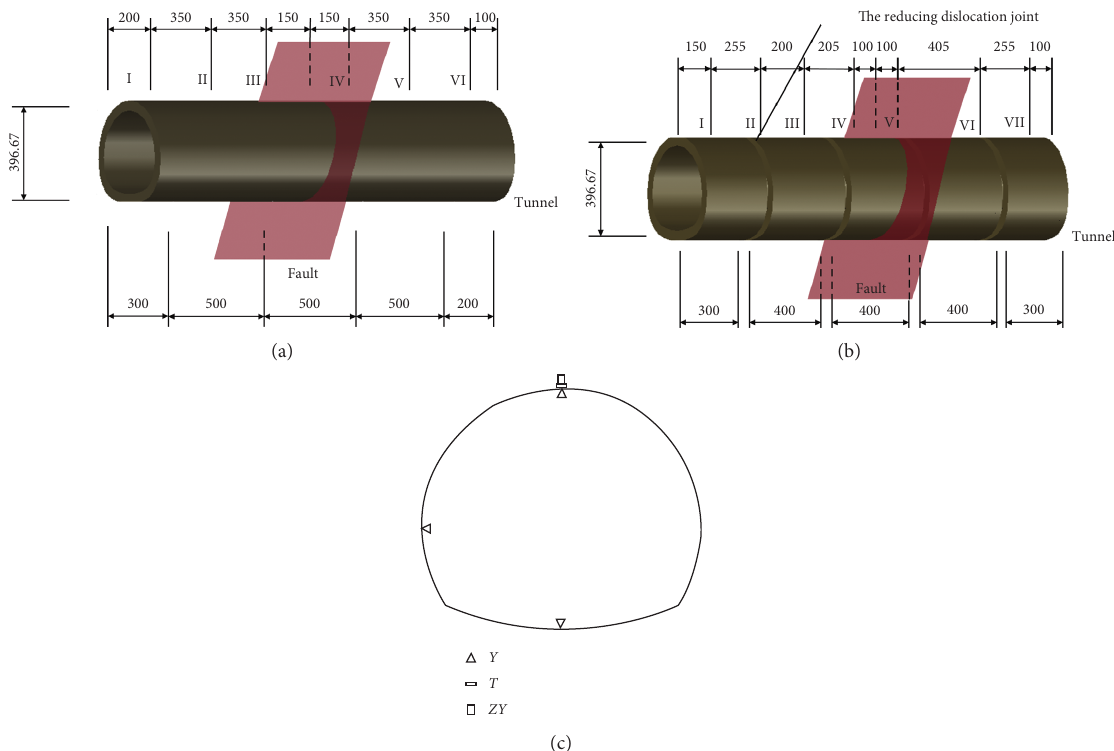
Figure 6: Arrangement of testing section and measuring points. (a) The measuring section of operating conditions 1 to 3 (unit: mm). (b) The measuring section of operating conditions 4 to 5 (unit: mm). (c) Arrangement of the measuring